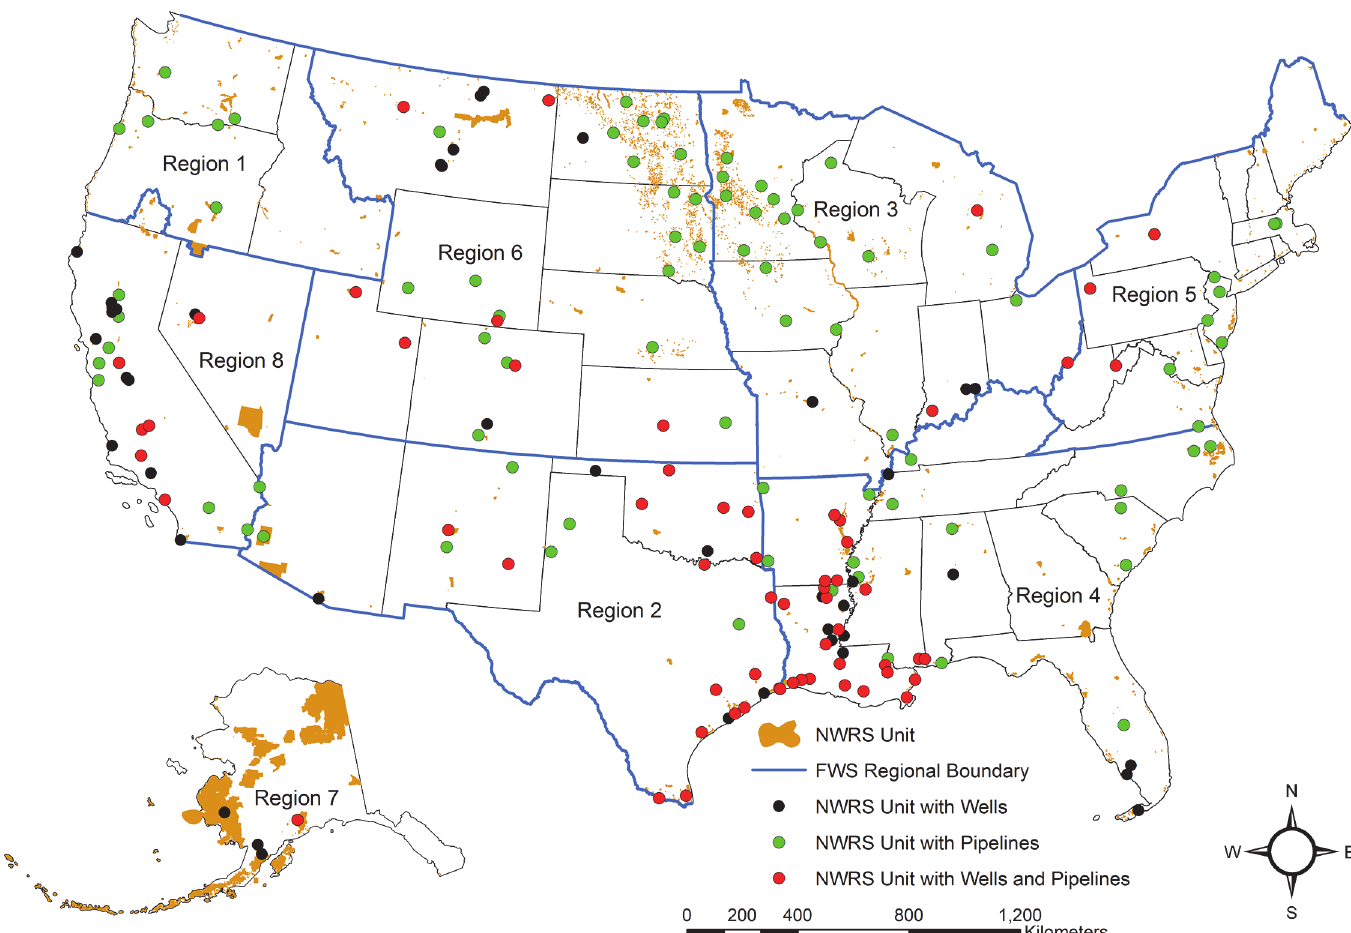
Fig 2. NWRS Units with Wells and Pipelines. Locations of National Wildlife Refuge System Units with oil and gas exploration and production wells and interstate pipelines. NWRS Units with no wells or pipelines (orange), NWRS Units with oil and gas exploration and production wells and no pipelines (black), NWRS Units with pipelines and no wells (green), and NWRS Units with wells and pipelines (red).